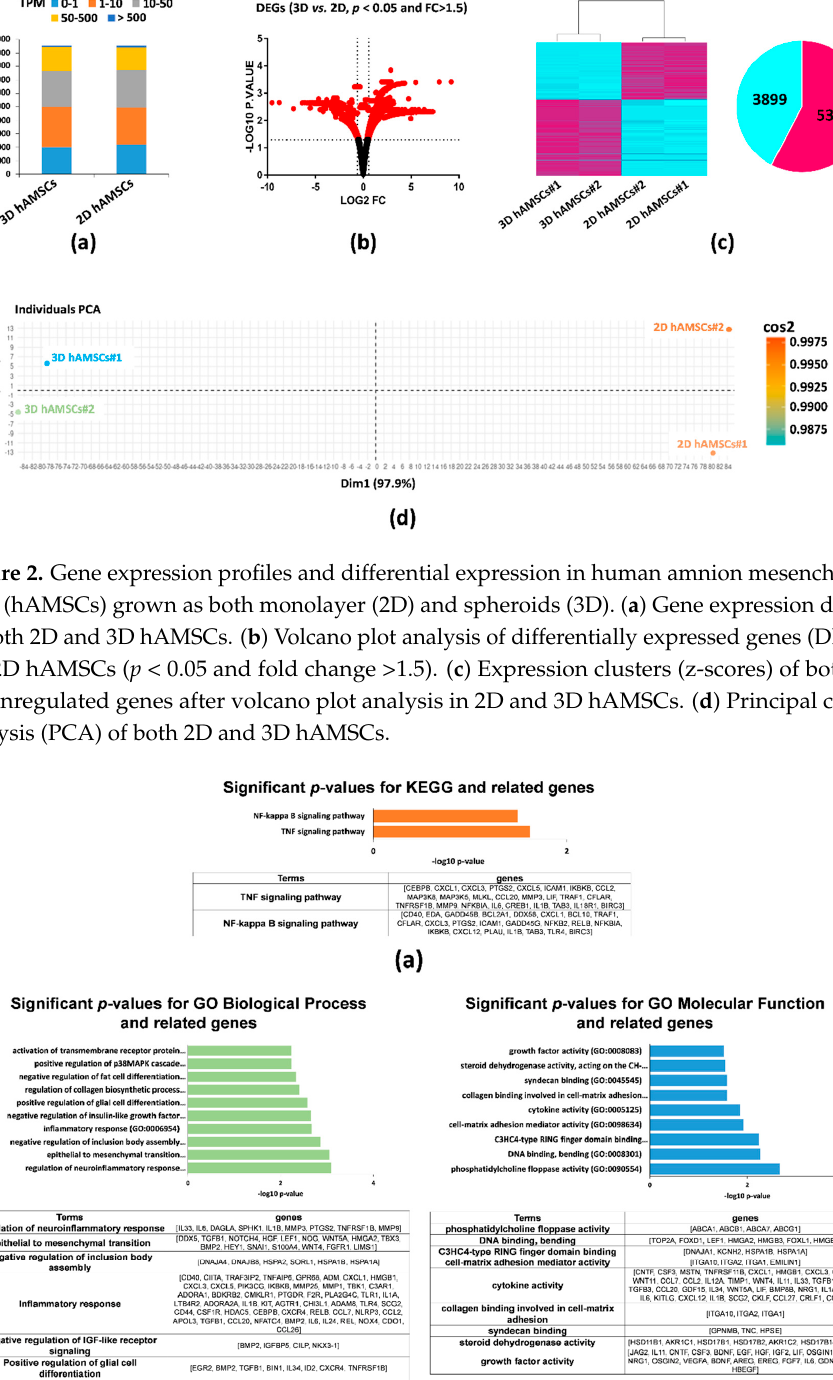
angiogenesis pathways (Figure 4d).